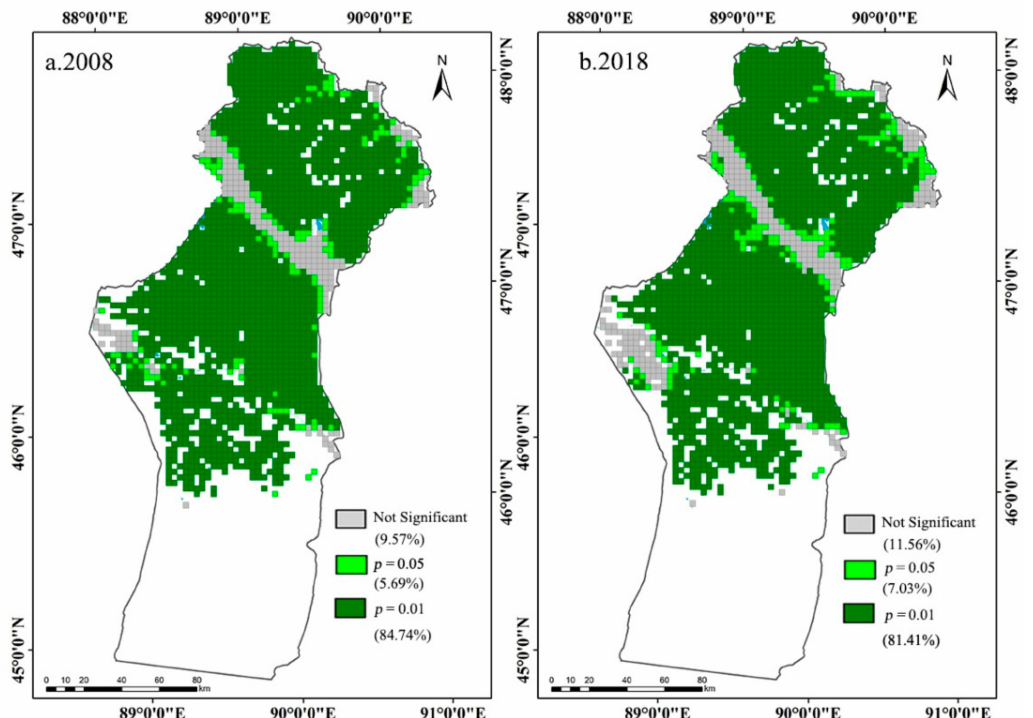
Figure 5. LISA significance map of MODEI in Fuyun